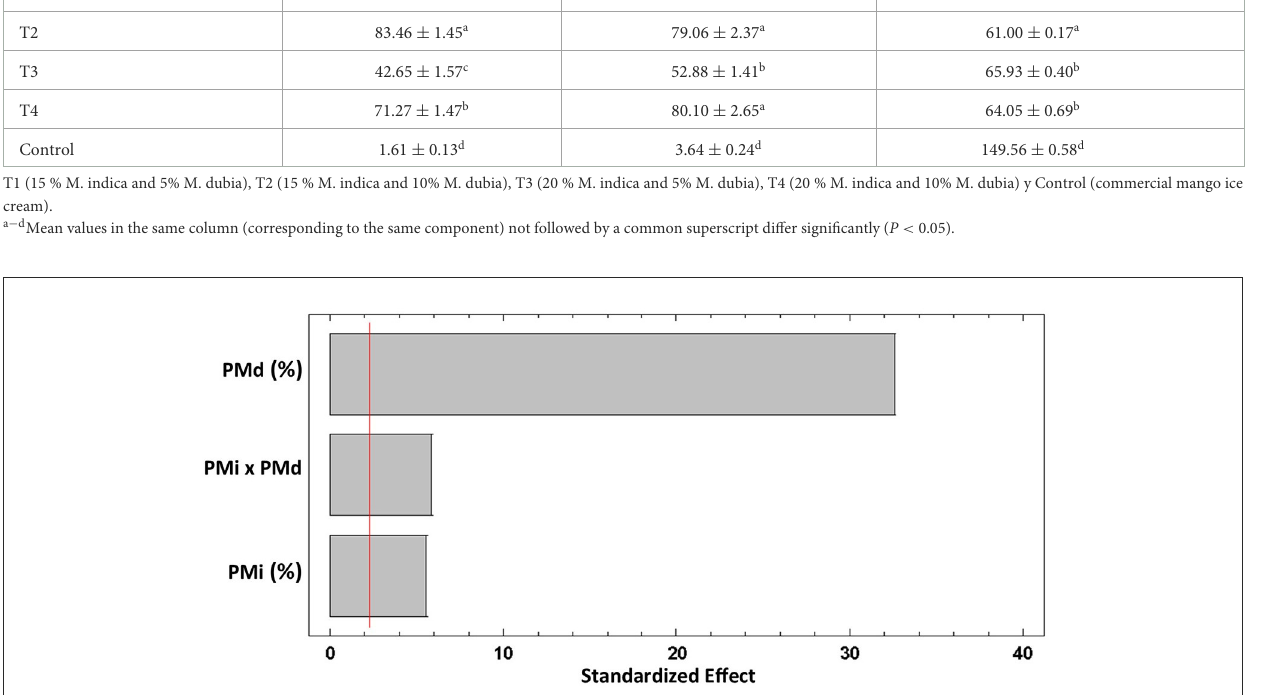
of TPC is observed during storage at − 22 ◦ C, after 30 and 72 days, reducing between 10 and 80% of TPC in samples of ice cream enriched with herbal extracts (mate and lemon balm), which suggests a short life span for this type of product (Gremski et al.,